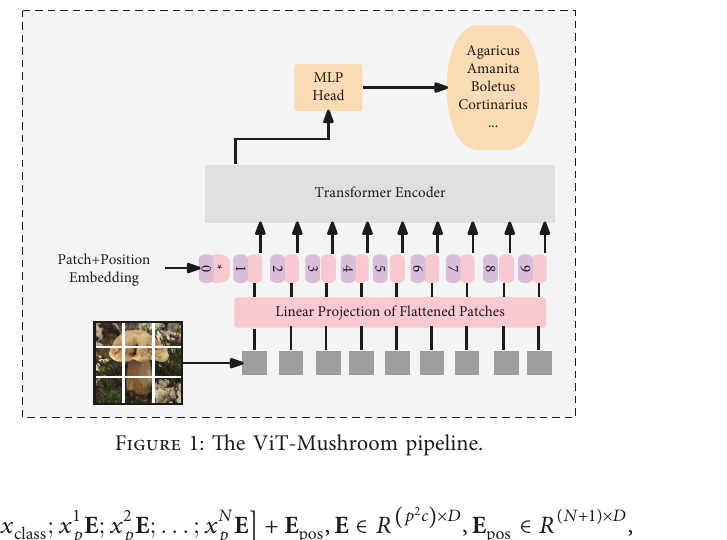
Figure 1: The ViT-Mushroom